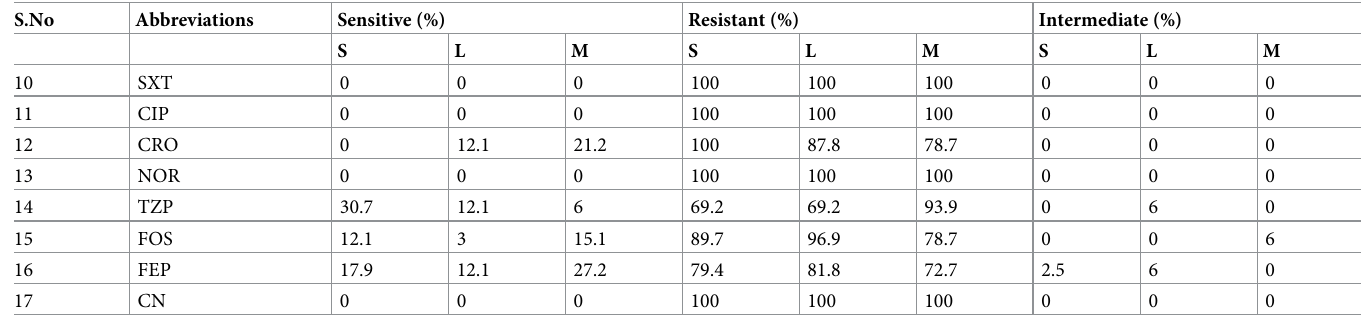
incubation, presented a leaf like flattening at the center showing positive results as shown in